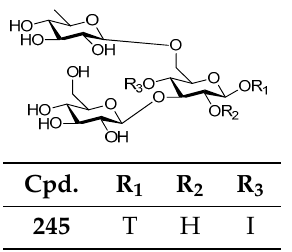
Figure 51. Structure of compound 245